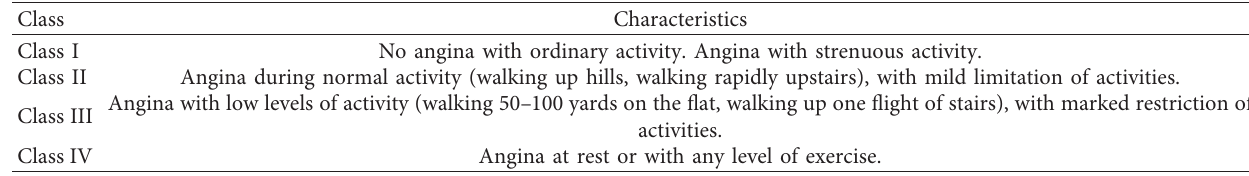
Table 2: Canadian Cardiovascular Society’s classification of angina [13].